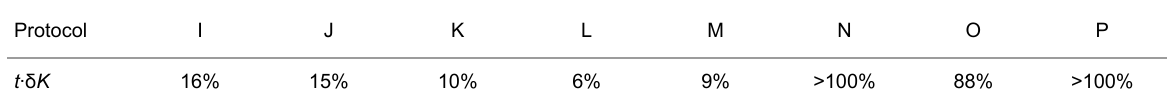
Table 2: Theoretical uncertainties of K for an individual analysis of the eight competitive ITC protocols described in Figure 4, in the case of the HP β -CD-IBU complex at 283 K (total concentrations are considered as perfectly known). Protocol